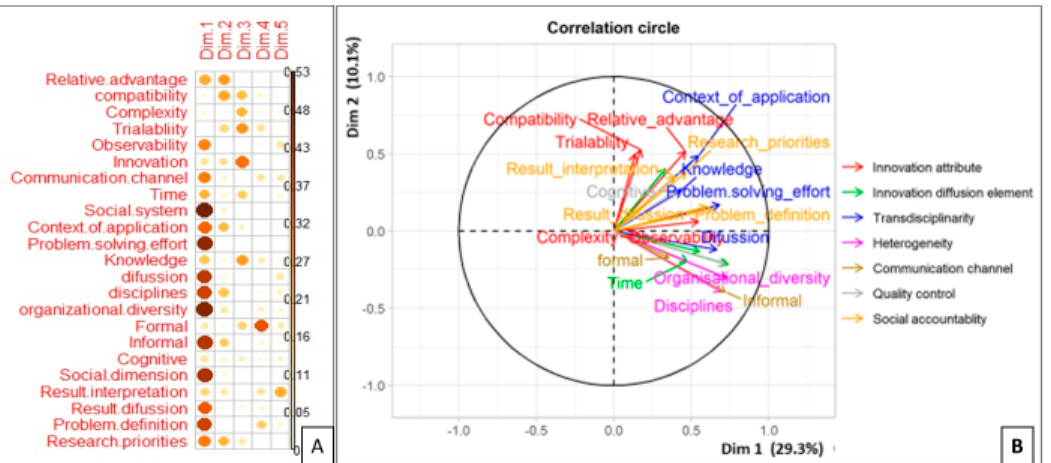
Figure 3. Contribution of 23 variables to the first five dimensions ( A ) and the correlation circle of dimensions 1 and 2 ( B ).